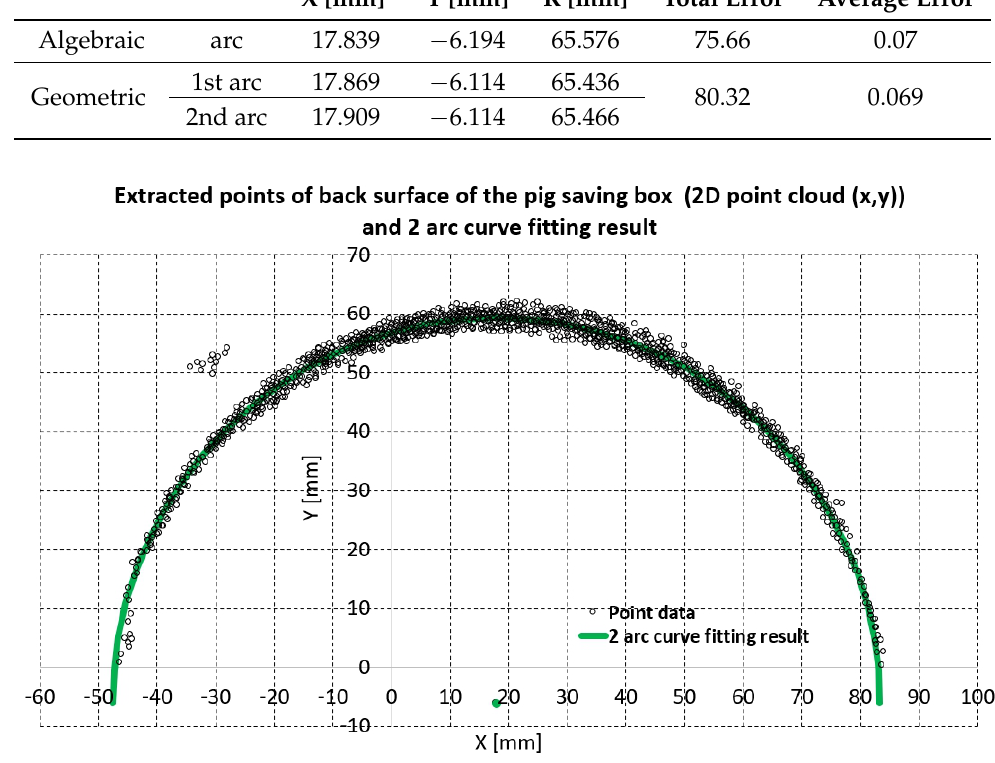
Figure 6. Piecewise curve fitting results of the back surface of the piggy bank (in total, 1164 points). The first and second arcs made via geometric method in Table 1 are almost the same; therefore, the two green arcs look like one